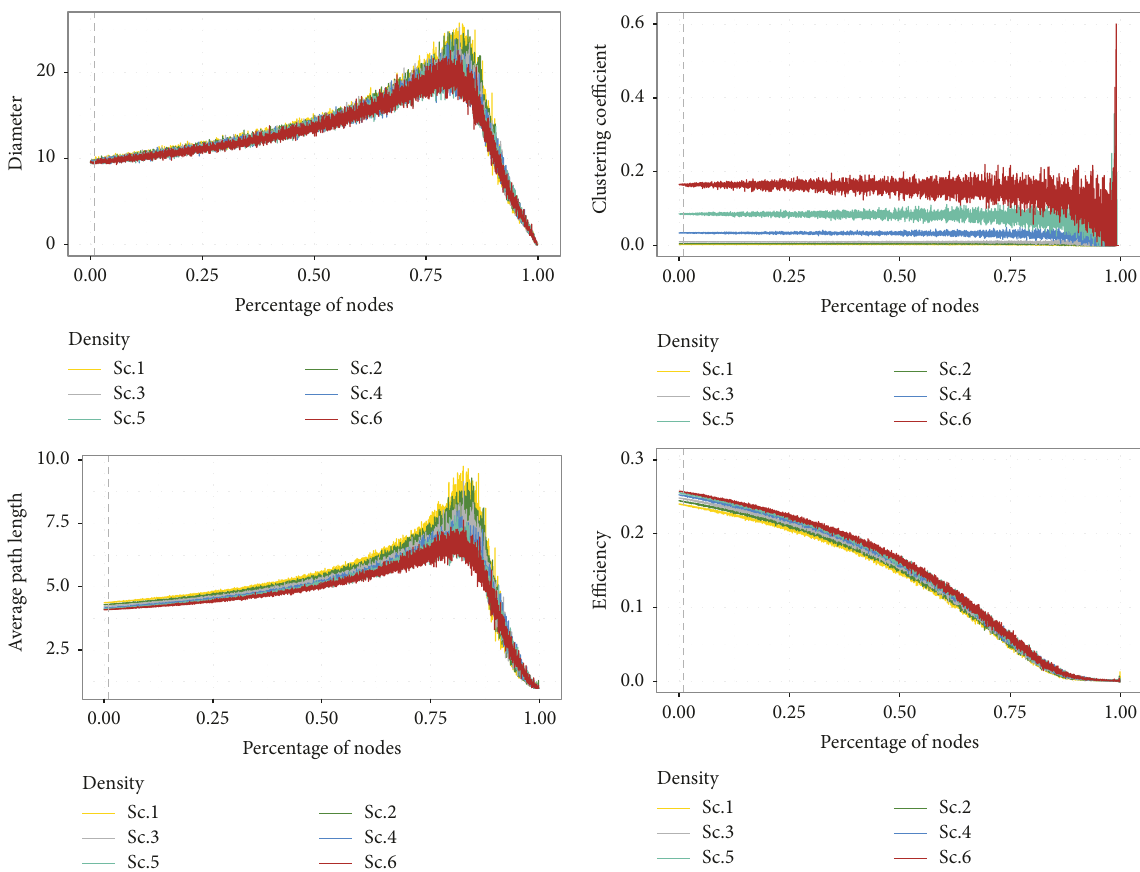
Figure 5: Resilience for simultaneous error simulations with progressive manipulation of the number of links in the network core. The dashed line is placed in correspondence with the rich-club size. All results are averaged over 10